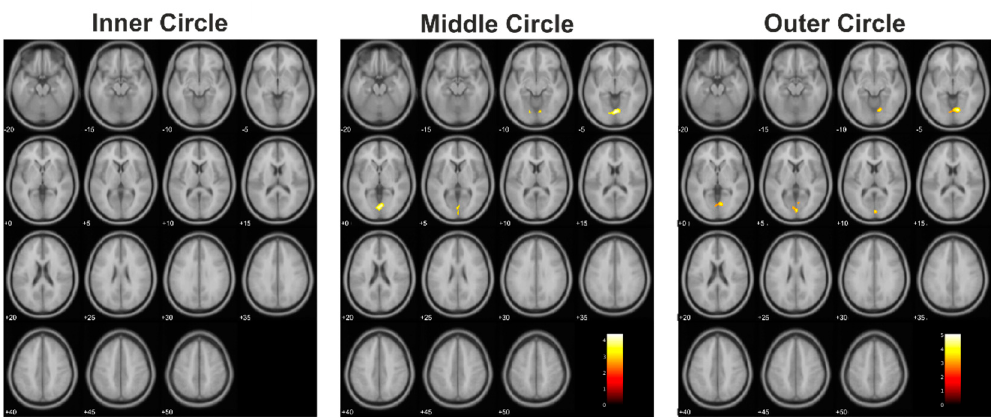
Figure 3. The resulting statistically significant differences of the comparison of the controls > tumor patients. Table 2. Significant differences in brain activation when comparing the respective healthy control subjects to the tumor or lesion patients. Group